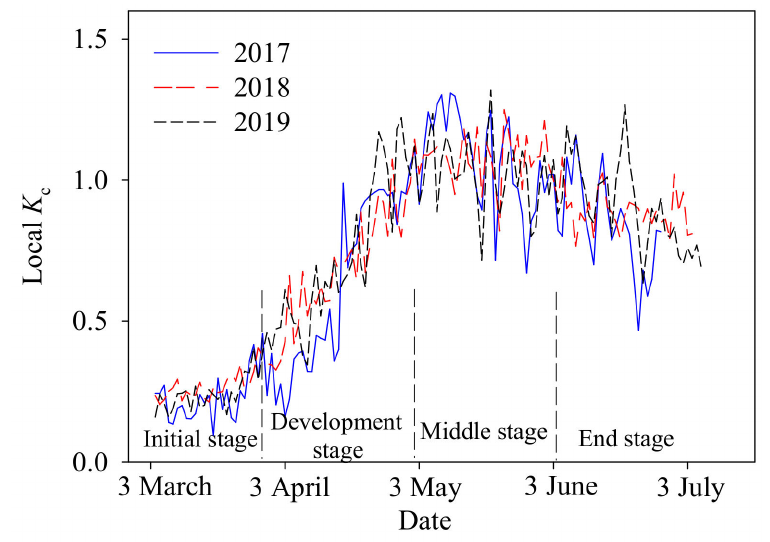
Figure 4. Variation in daily local crop coefficient ( K c ) of greenhouse-grown eggplant in the 2017, 2018, and 2019